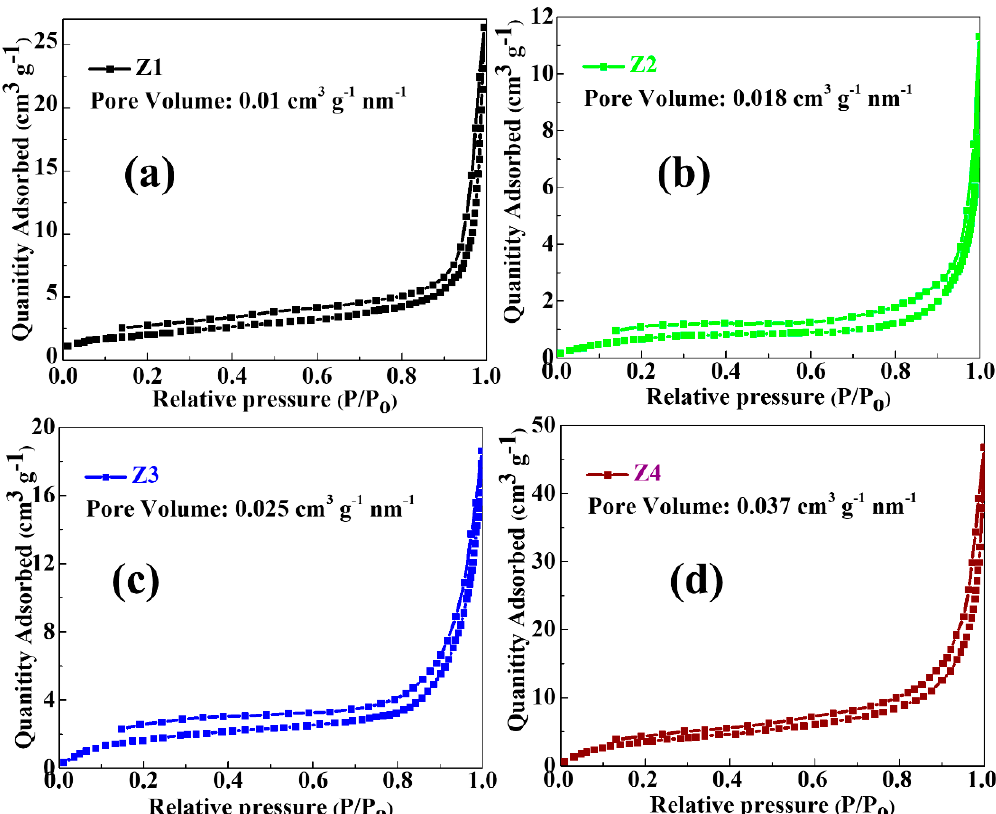
Figure 11. ( a )–( d ) N 2 adsorption isotherms for different ZnO synthesized @80 °C samples used for Figure 11. ( a – d ) N 2 adsorption isotherms for di ff erent ZnO synthesized @80 ◦ C samples used for catalytic activity. catalytic